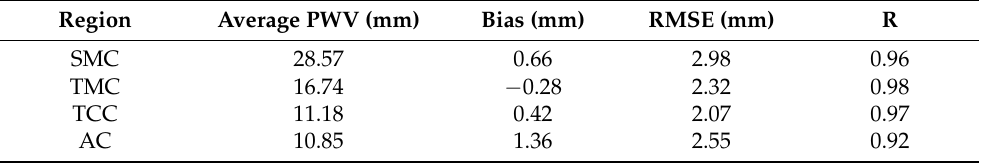
Table 1. Bias, RMSE, and correlation between the ERA5 PWV and GNSS PWV. Region